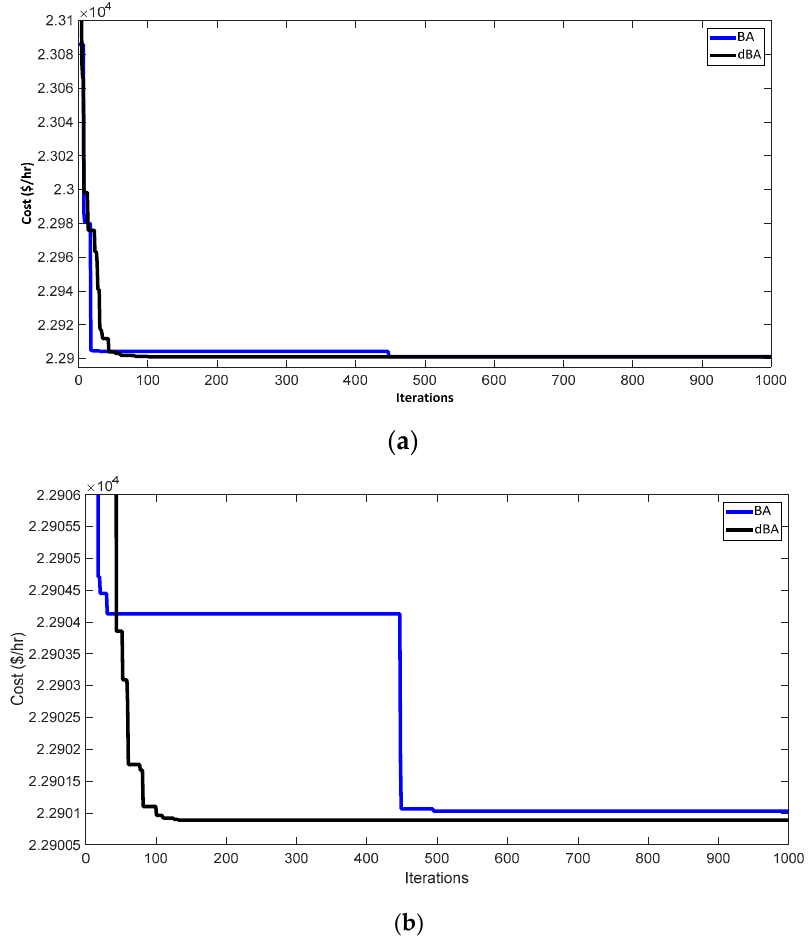
Figure 7. Convergence curve: ( a ) The cost convergence curve by the BA and dBA (seven-unit system